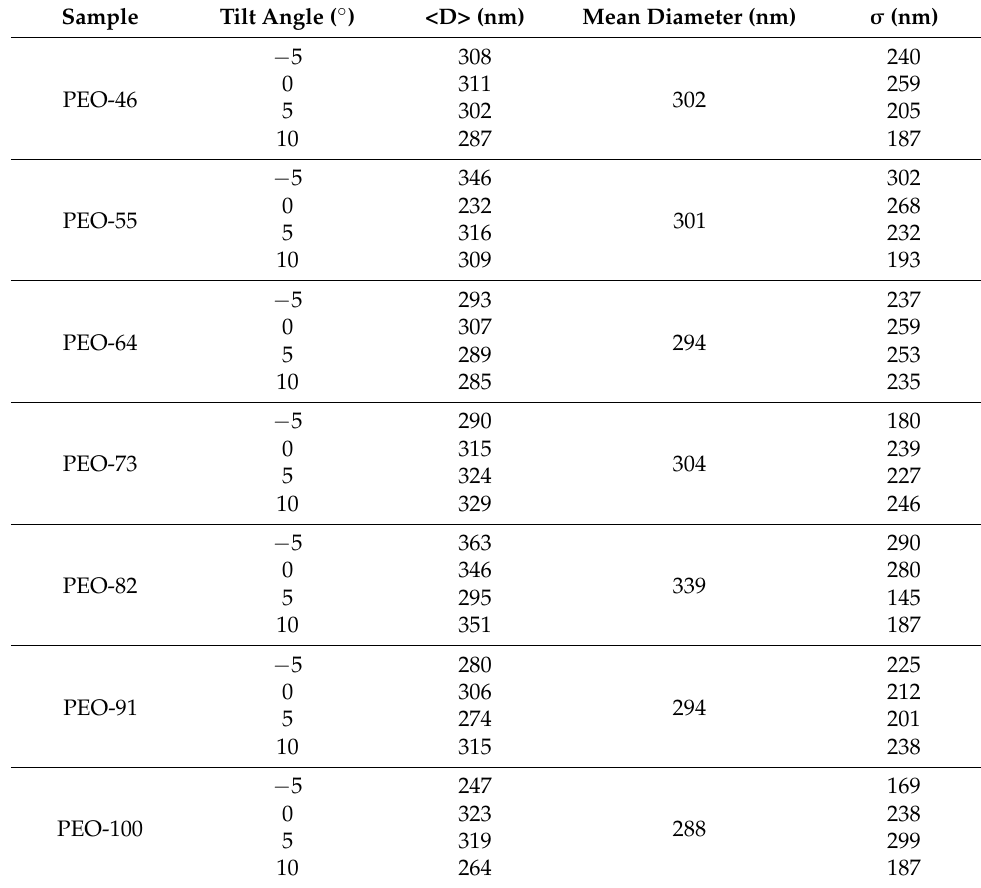
Table 4. Morphological parameters of the blow spun fibers extracted from the SEM images